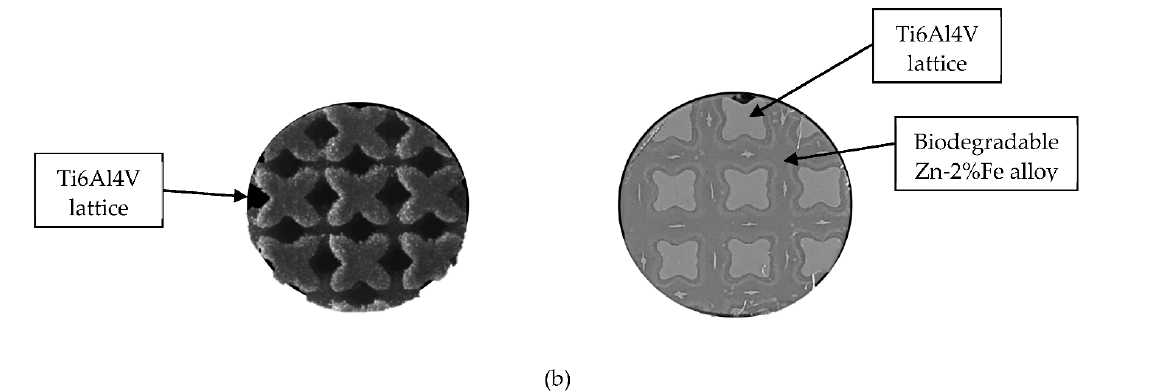
Figure 1. ( a , b ) General and close-up views of Ti-base lattice and infiltrated lattice (OI–TiZn system), respectively. A close-up view of the boundary between the Ti-base lattice and the infiltrated Zn– 2%Fe alloy, as obtained by SEM back scatter electron (BSE) analysis, is shown in Figure 2a. A magnified view of that boundary clearly discloses the presence of an interface layer with a width of about 130 µm attached to the Ti-base rods, as shown in Figure 2b.